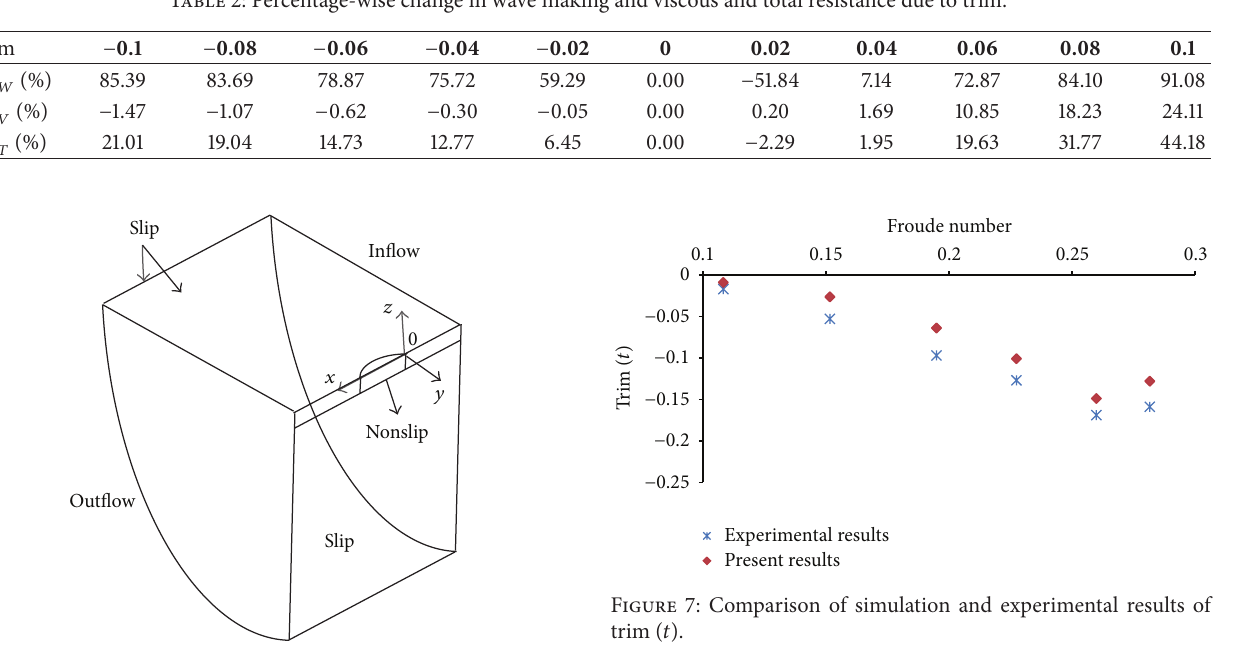
Figure 5: Computational domain around hull.